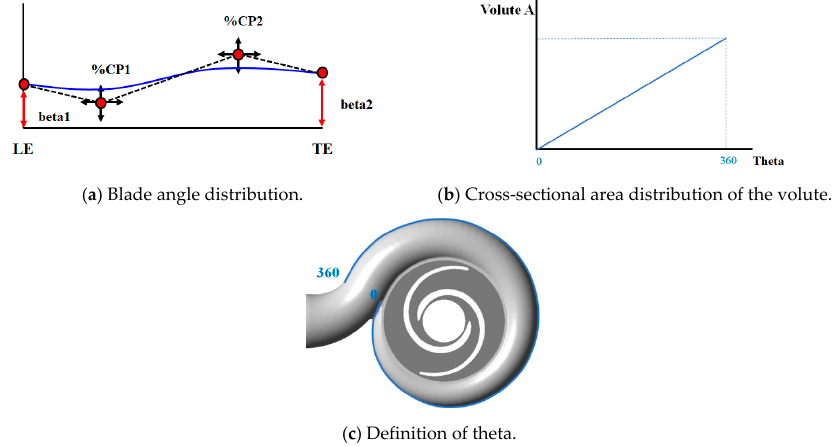
Figure 6. Definition of the waste solid volume.